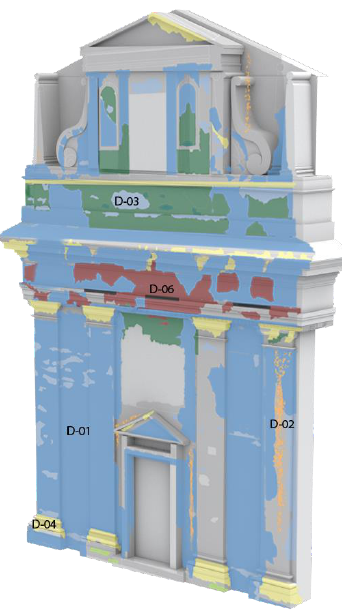
Figure 14. 3D thematic mapping of material